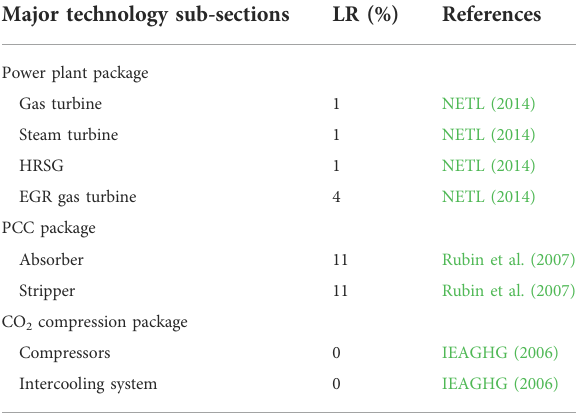
TABLE 2 Learning rates (LR) used for each major technology sub-